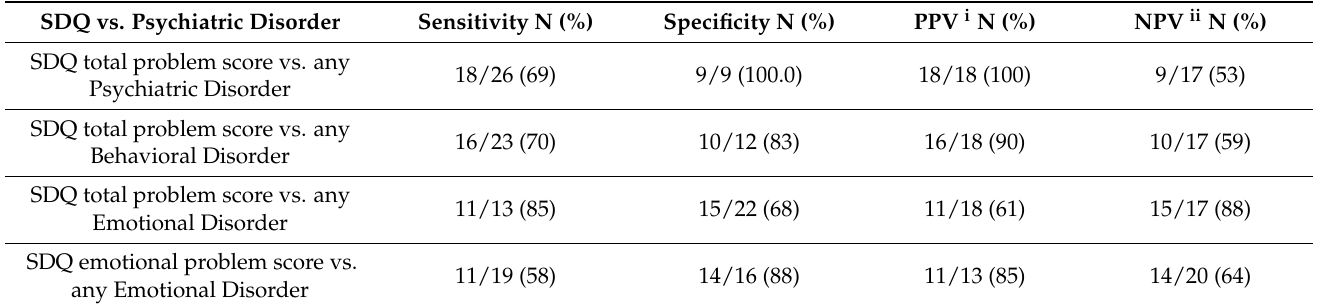
Table 4. Validity of parent-reported Strengths and Difficulties Questionnaires (SDQs) using the 90th percentile cut-off score assessed according to Psychiatric Disorders in children with Cerebral Palsy at